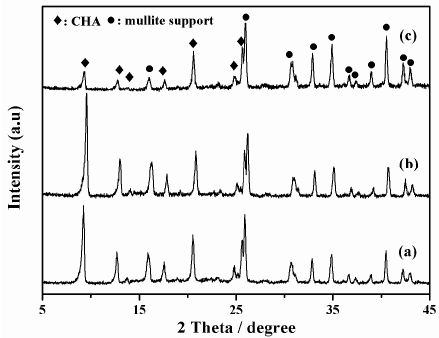
Figure 6. XRD patterns of high silica SSZ-13 zeolite membranes with different TMAdaOH/SiO 2 ratio, ( a ) M-7, TMAdaOH/SiO 2 = 0.05; ( b ) M-4, TMAdaOH/SiO 2 = 0.10; ( c ) M-8, TMAdaOH/SiO 2 = 0.15.